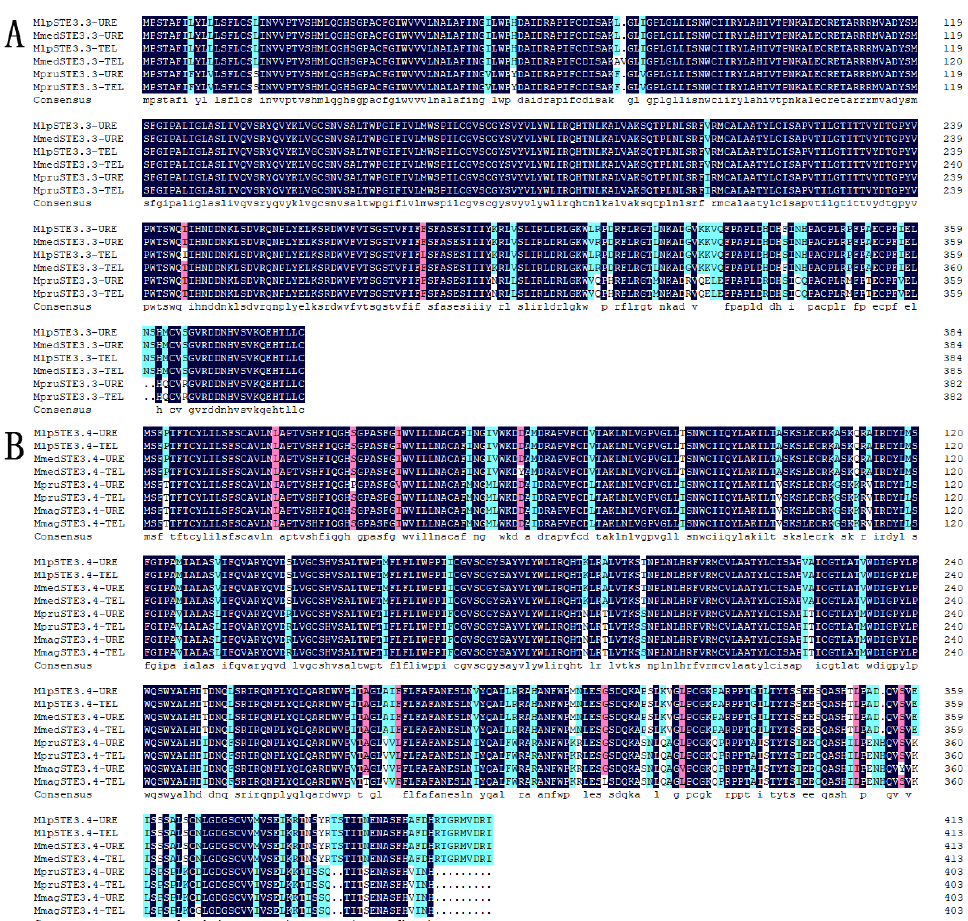
Figure 1. Homologous alignment of amino acid sequences of STE3.3 and STE3.4 in Melampsora. Note: Dark background refers to 100% identical; pink background refers to 75% to 100% identical; blue background refers to 50% to 75% identical; white background refers to lower than 30% identical; ( A ), STE3.3; ( B ), STE3.4.